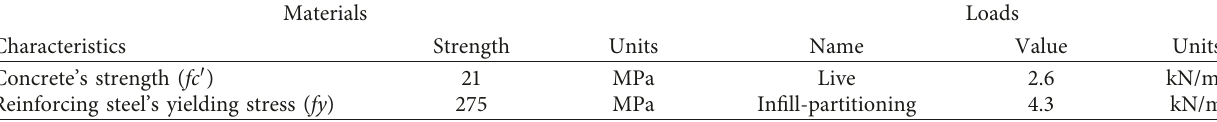
Table 3: Material strengths and loading values used for the structural